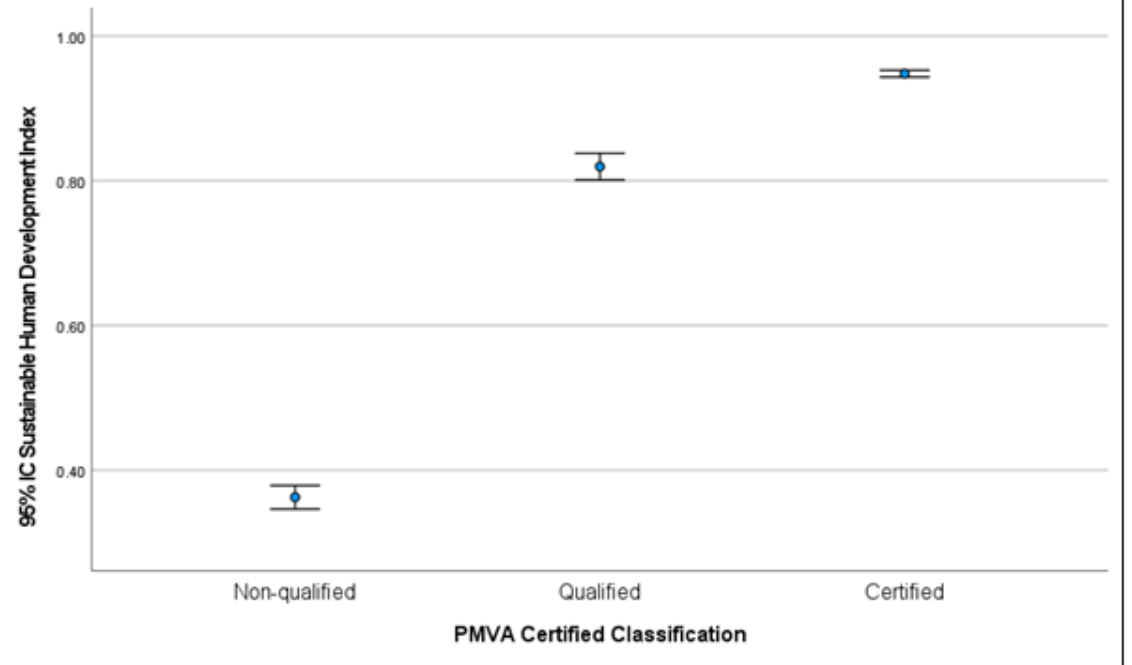
Figure 3. Error bar graph of the municipalities by classification of the PMVA.